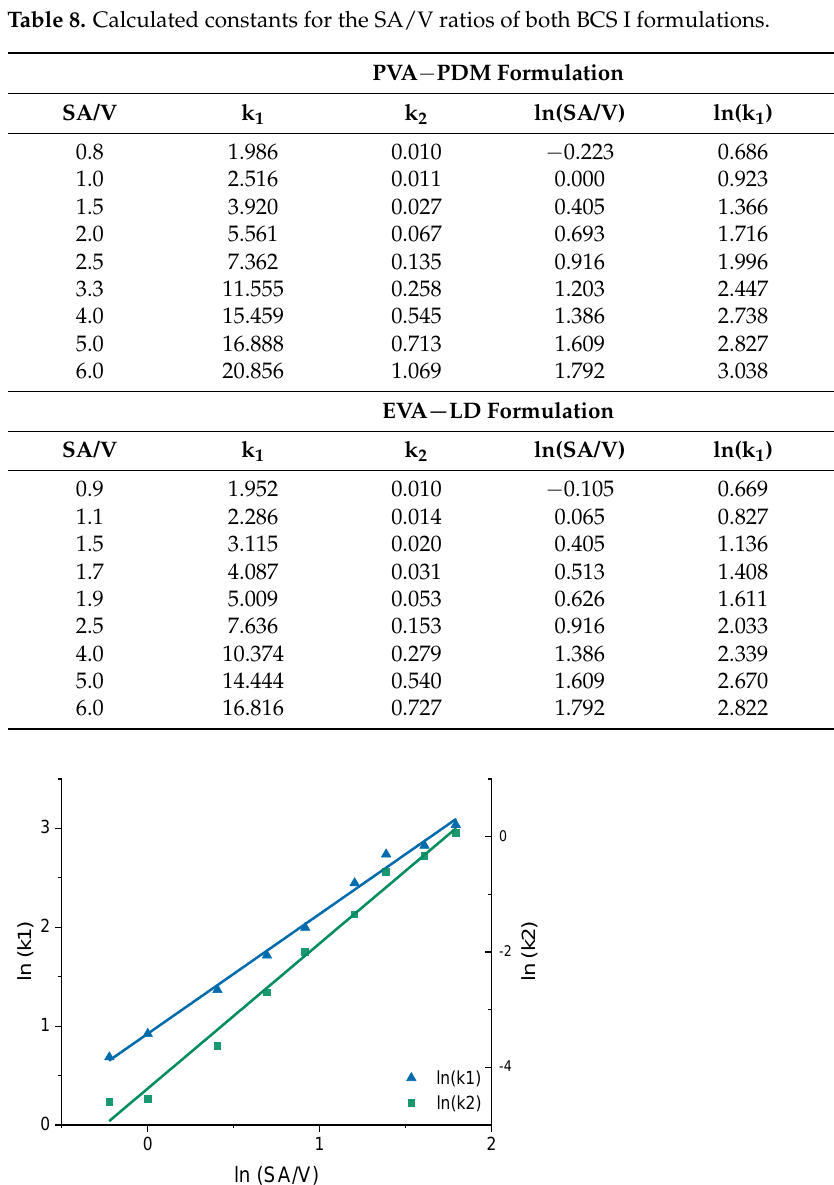
Figure 7. Correlation of the constants k 1 and k 2 of the Peppas Sahlin equation with the SA/V ratio for the PVA-PDM formulation.